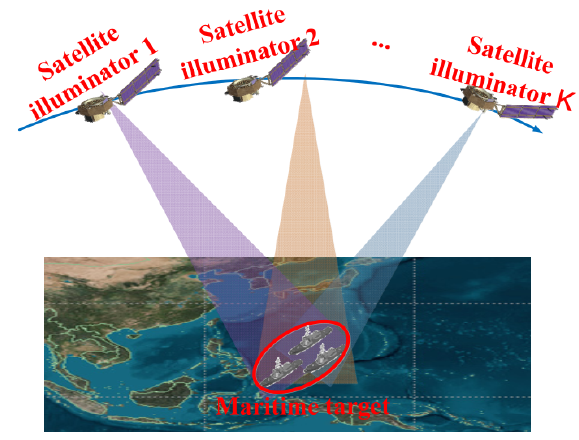
Figure 1. Multi-source fusion detection